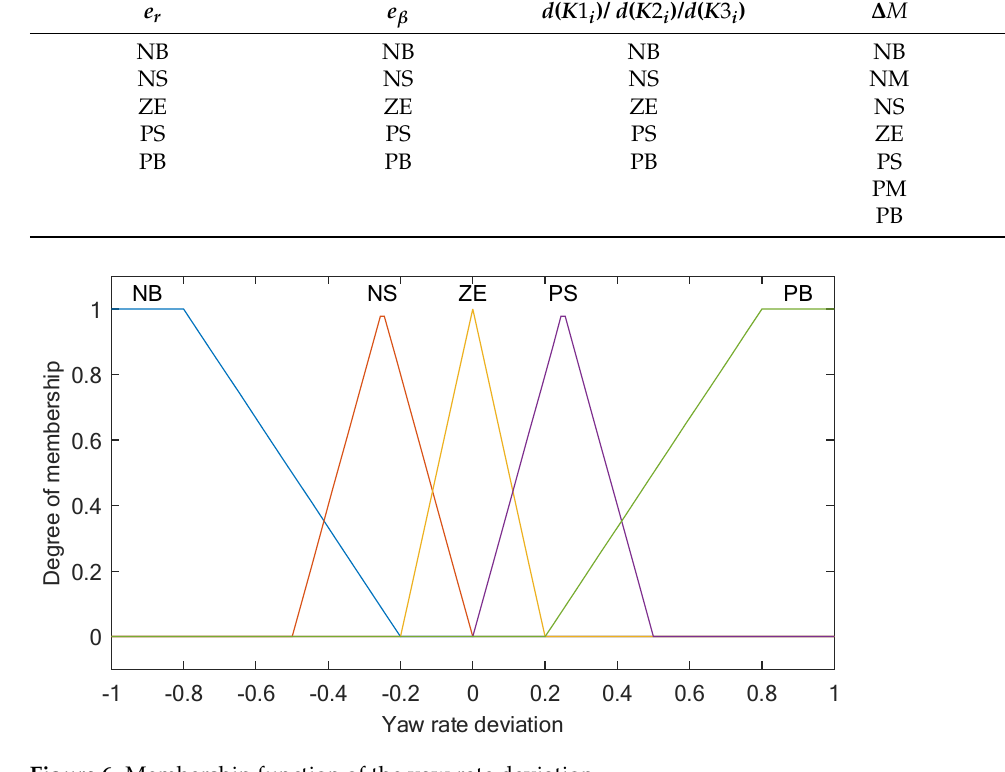
Figure 8. Membership function of the additional yaw moment. Fuzzy reasoning is the core link in fuzzy control, which is to form a one-to-one rule relationship between the input variable combination of the fuzzy controller and the out- put variable based on expert experience. The self-correction of K1, K2 and K3 is realized according to different driving condi- tions of the vehicle. When the vehicle is running at low speeds and turning, the yaw rate has great control, so it is necessary to appropriately increase the quantization factor K1 and increase the scaling factor K3 to improve the response speed. When the vehicle is running at a medium-high speed and turning, the yaw rate at the small corner is equiva- lent to the control weight of the sideslip angle, and the quantization factors K1 and K2 need to be increased. K3 should be reduced to maintain the driving stability. At the large corner, the sideslip angle needs to be controlled first. The quantization factor K2 needs to be increased appropriately, and the scaling factor K3 needs to be reduced to ensure the stable running of the vehicle [25]. The adjustment rules and global fuzzy logic rules used in this paper are shown in Tables 3 and 4, each with 25 fuzzy rules.